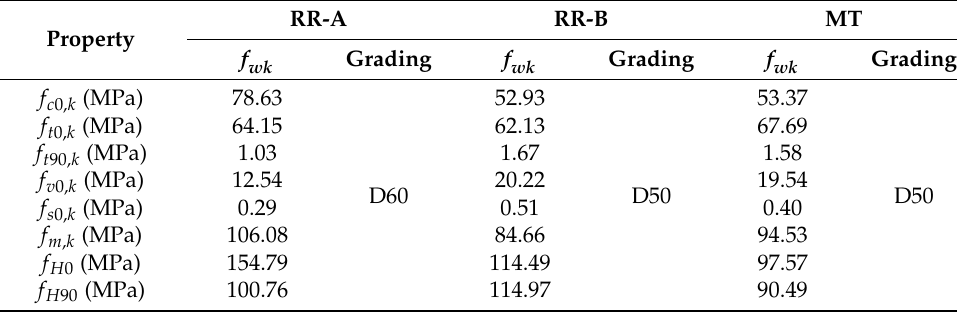
Table 4. Characteristic strength and strength class for each harvesting region